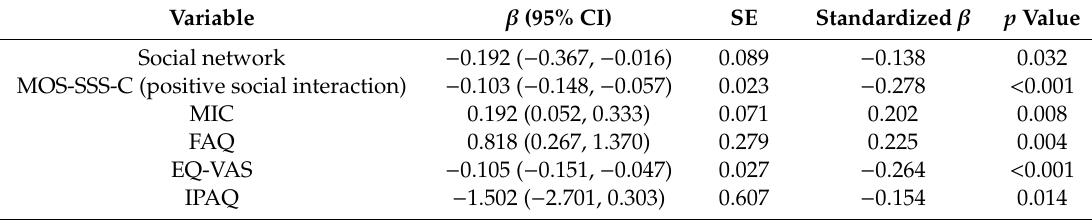
Table 3. Multiple regression analysis for the correlates of the GDS-C score in patients with MCI ( N =